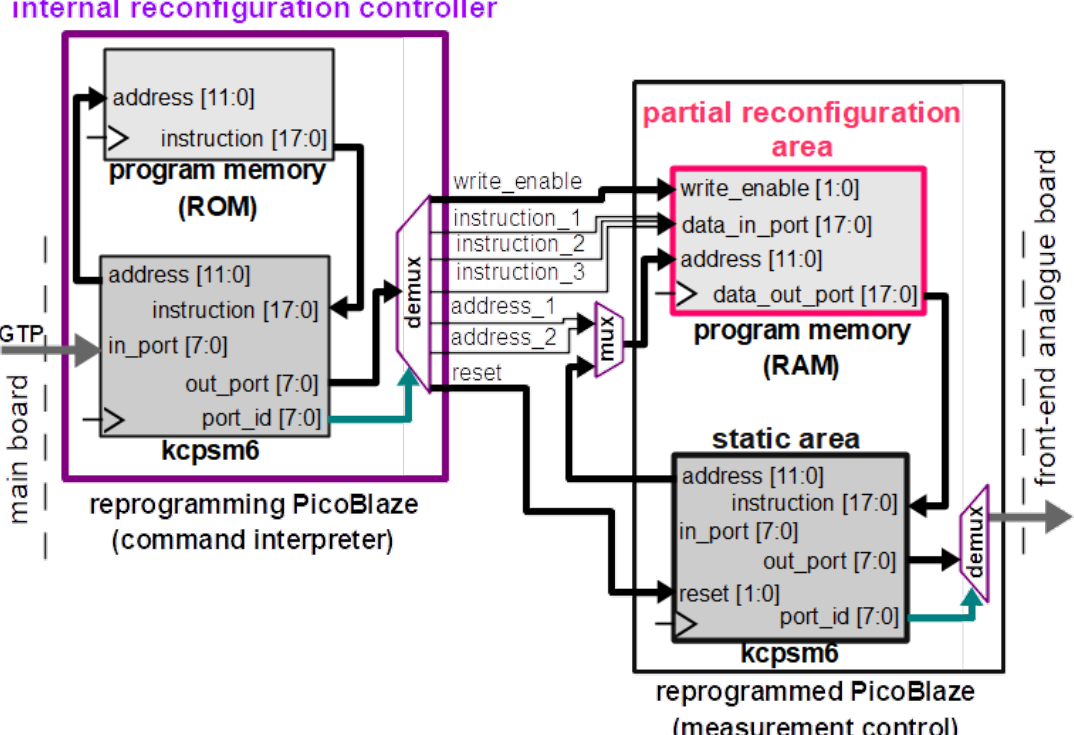
Figure 3. Reconfiguration block providing access to the PicoBlaze program code memory.